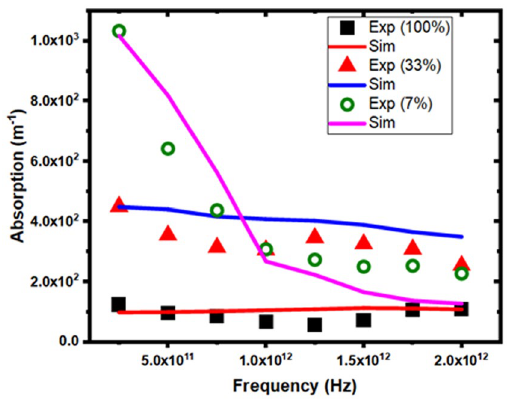
Figure 1. Absorption spectrum at peak THz intensity 1 (7%), 5 (33%), 15 (100%) MV/m with varying THz Frequencies. Data from present work is displayed as solid lines where as experimental results taken from reference 1 are depicted by circles, triangles and squares respectively.